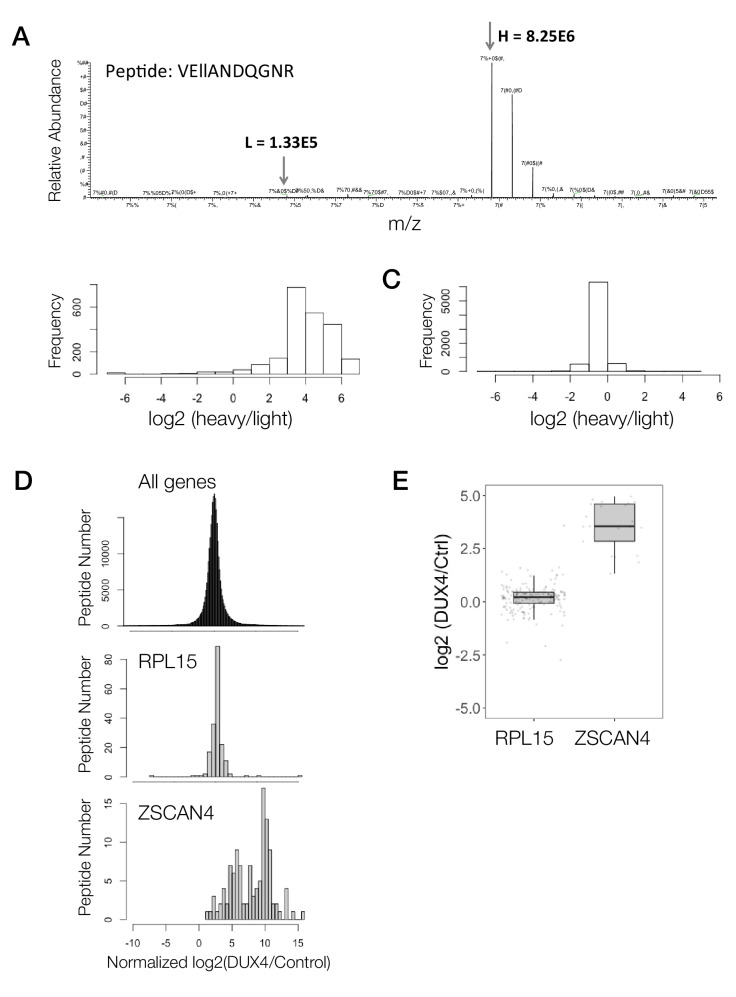
Demonstration of peptide to protein summarization for two candidate genes.(A) The mass spectra for a representative peptide from a heavy-labeled sample. (B) Histogram of log2-ransformed heavy to light ratio of peptides from cells labeled with heavy amino acids for 1 week. (C) Histogram of log2-transformed heavy to light ratio of peptides from an equal mixture of unlabeled cells with cells labeled with heavy amino acids for 1 week. (D) Histogram shows the DUX4/Control ratios (log2) for all peptides in the iDUX4 dataset (top panel), for peptides mapping to RPL15 (middle panel) or for peptides mapping to ZSCAN4 (bottom panel). (E)Box and whisker plot showing the median log2 DUX4/control ratios for RPL15 and ZSCAN4.